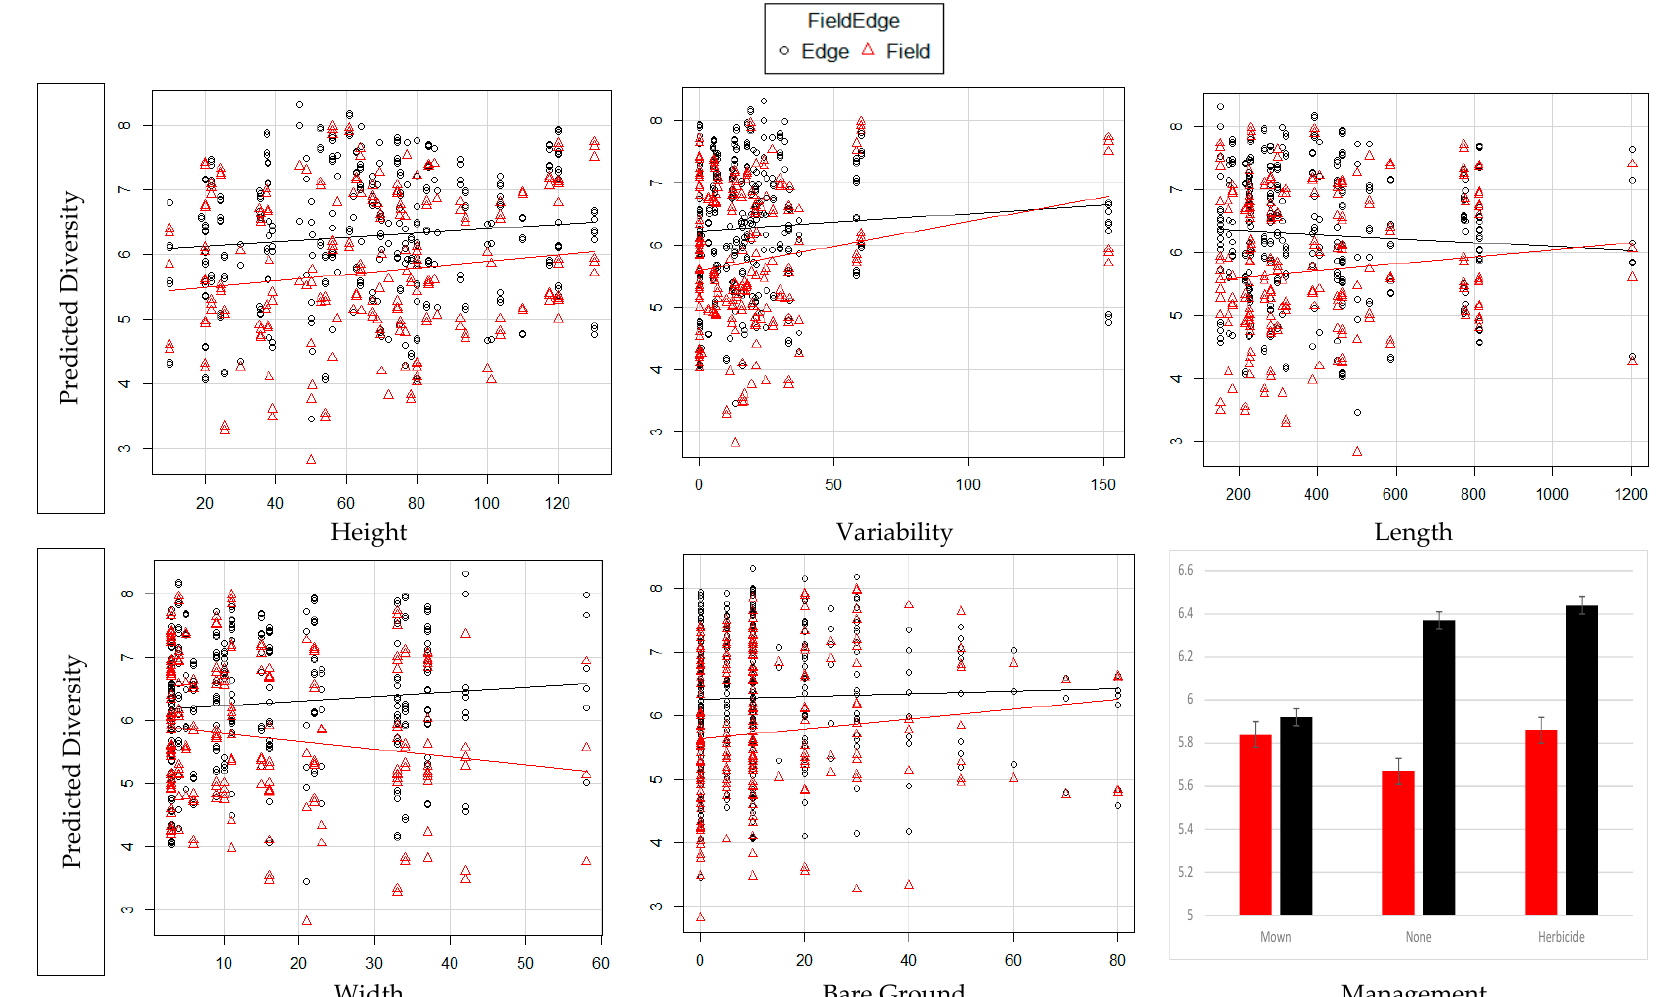
Figure 3 . Biomass in fields and edges as predicted by each of the edge variables. Figure 3. Biomass in fields and edges as predicted by each of the edge